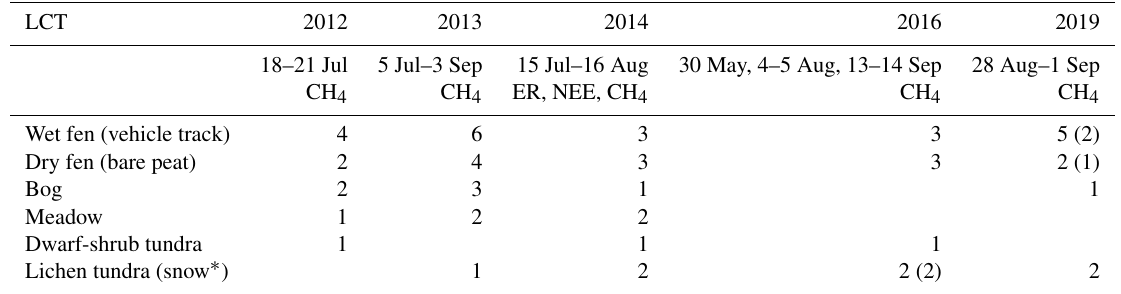
Table 2. Measurement periods, measured fluxes (CH 4 , ER, NEE), and number of measurement points in each land cover type (LCT) across the study